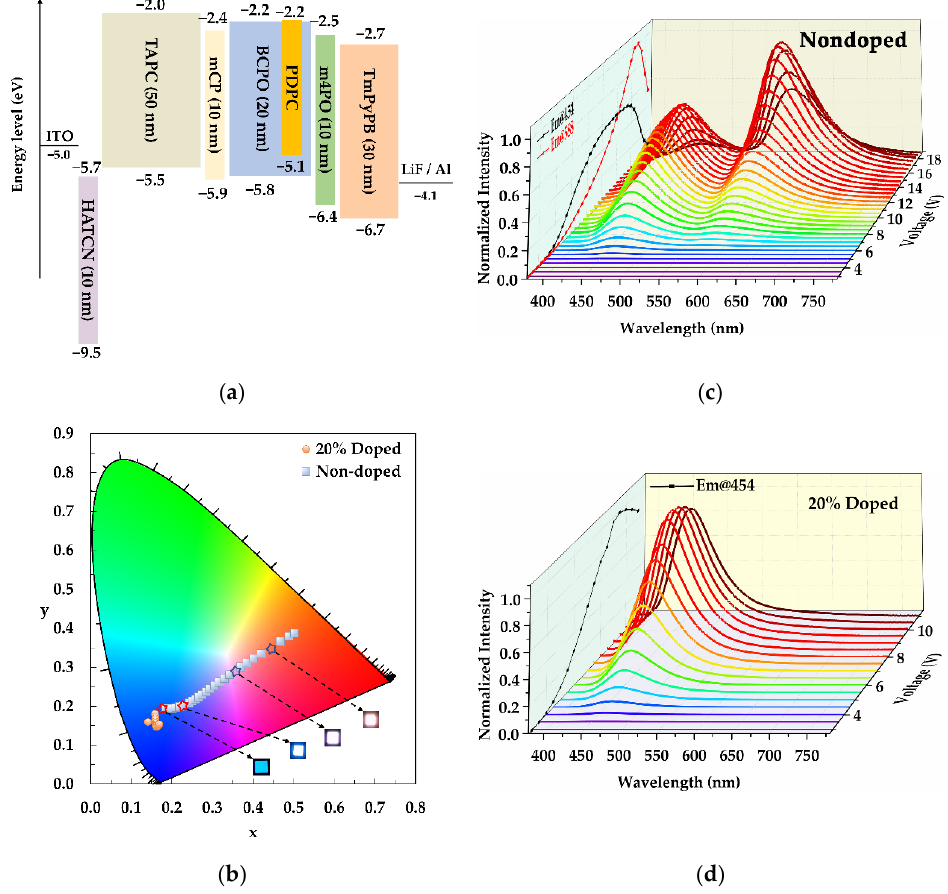
Figure 5. ( a ) Diagram for each layer in the fabrication of devices; ( b ) the coordinate plots of the nondoped and 20% doped devices on CIE 1931 color space; The electroluminescent curves of fabricated devices with an emitting layer for ( c ) nondoped and ( d ) 20% doped PDPC , under various voltages.